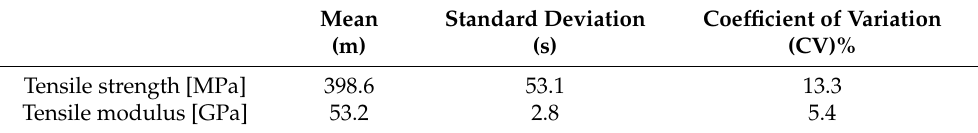
Table 6. Statistical indicators determined from tensile tests of A6 steel specimens.